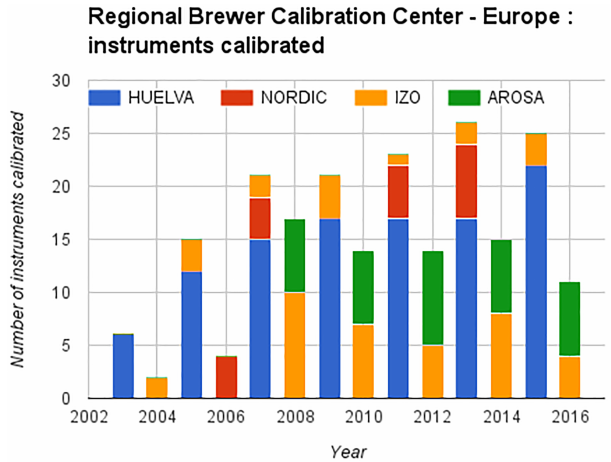
Figure 1. Brewer instruments calibrated since 2003 by the RBCC-E in regular campaigns (at Huelva and Arosa), Nordic intercompar- isons and the absolute calibrations performed at the Izaña Observa-